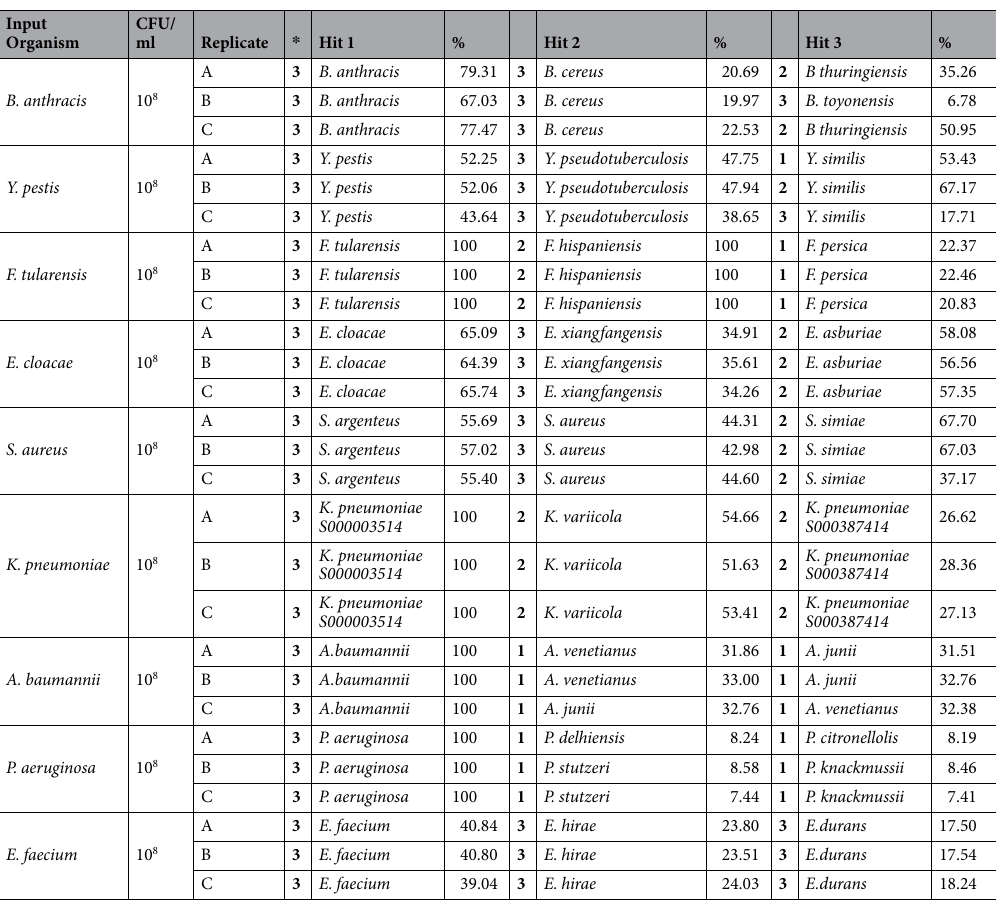
Table 1. Taxonomic classification of 16S sequencing reads using a simplified processing method for mapped sequencing reads. * Bold indicate number of databases a reference species